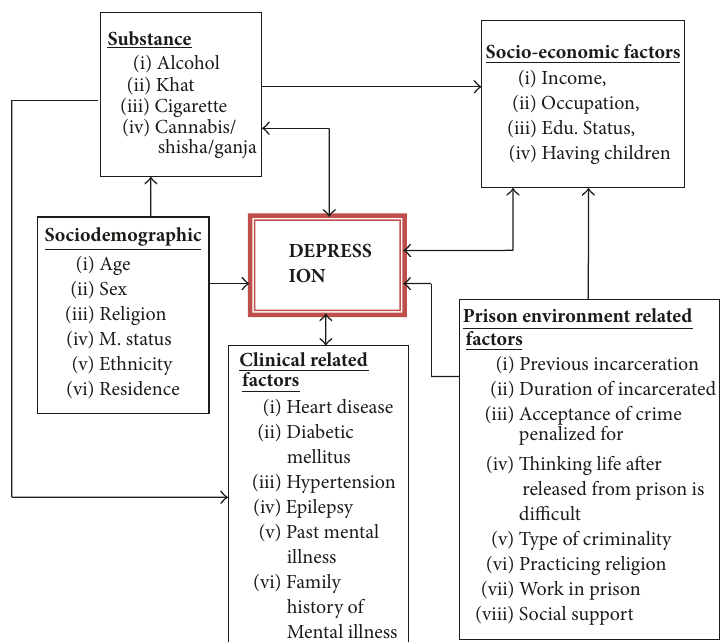
Figure 1: Conceptual framework of study on prevalence of depression and associated factors among prisoners in Jimma town Correctional Institution, South West Ethiopia, 2017 (source: developed by the principal investigator by reviewing literatures and scientific background).